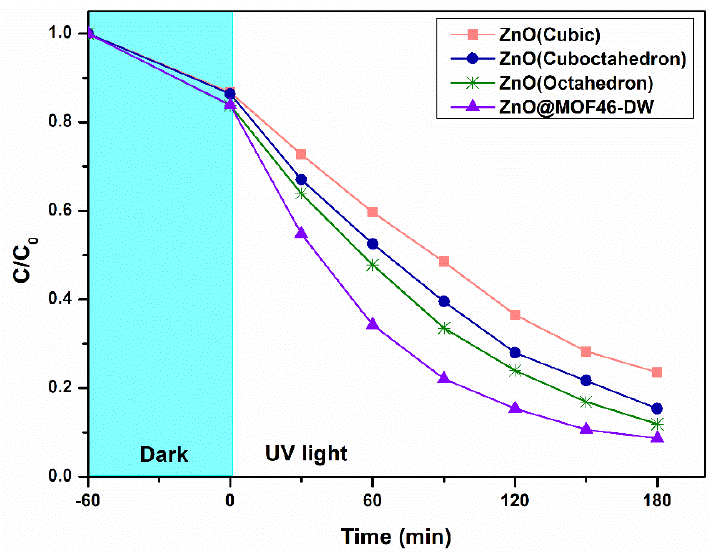
Figure 16. Relative methylene blue concentration change at various time intervals with prepared ZnO as the photocatalyst. ZnO as the